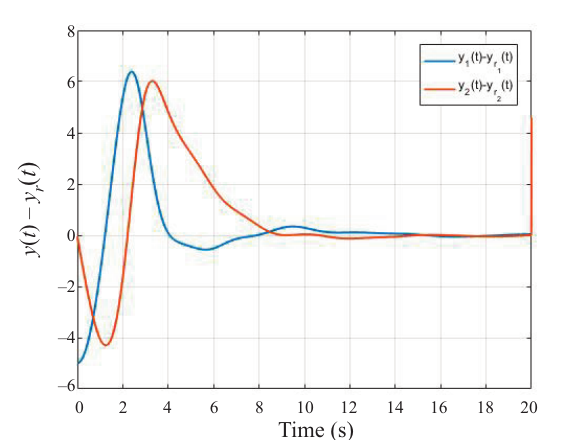
Figure 5. Output error y ( t ) − y